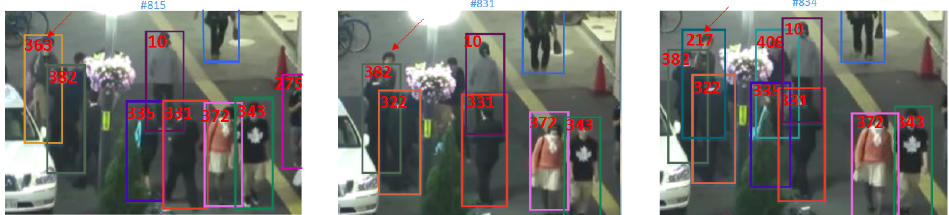
Figure 1. Illustration of the object misidentification problem caused by occlusions. The numbers above the pictures represent the frame numbers of the pictures. The red arrow points to the object we are tracking. The number in each object box represents the ID we assigned to the